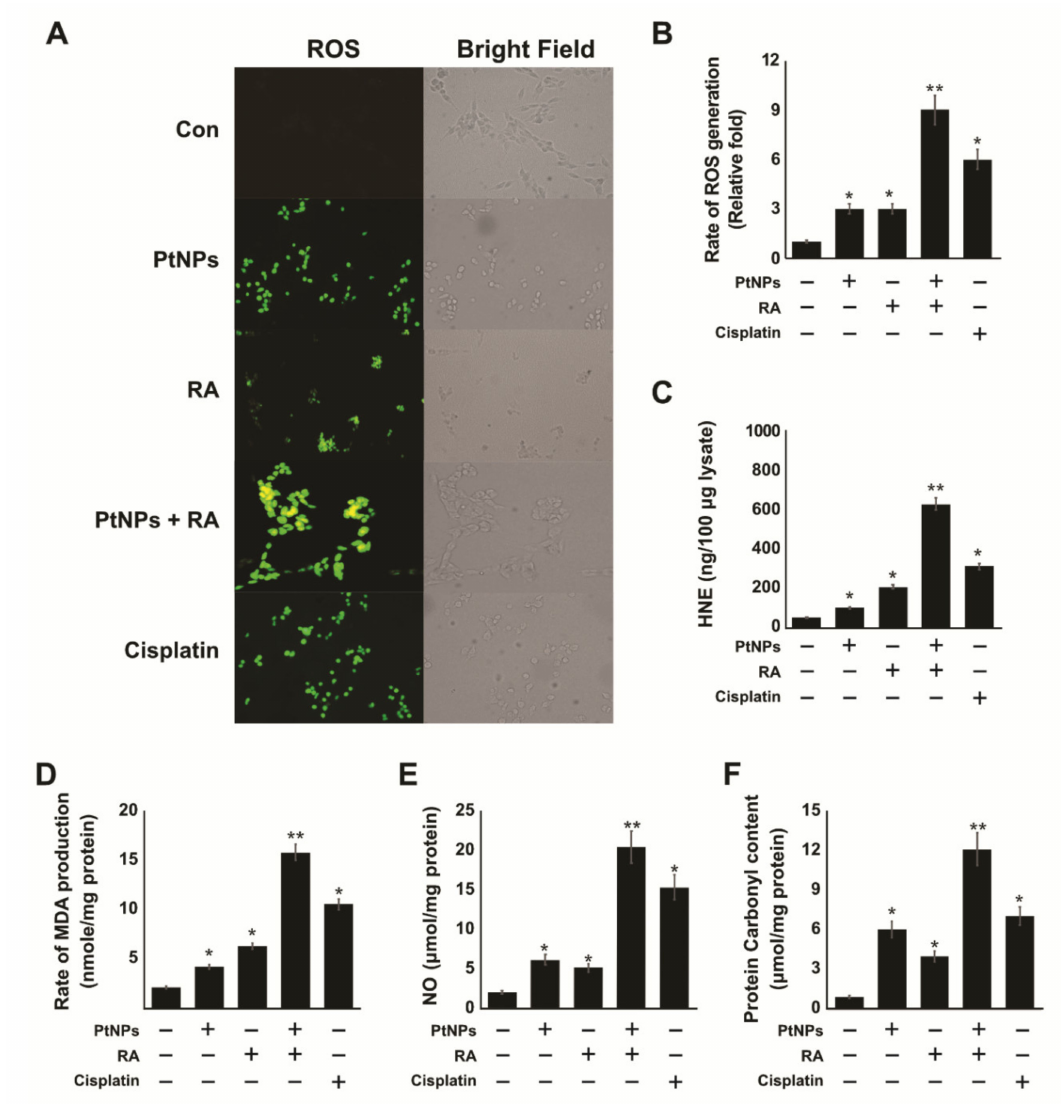
Figure 6. PtNPs and RA increase the generation of ROS, lipid peroxidation, nitric oxide (NO) level, and protein carbonylation. SH-SY5Y cells were incubated with PtNPs (25 µ g / mL), RA (12.5 µ M), combination of PtNPs (25 µ g / mL) and RA (12.5 µ M), or cisplatin (6.5 µ M) for 24 h. Treated SH-SY5Y cells were subjected to 2 (cid:48) ,7 (cid:48) -dichlorodihydrofluorescein diacetate-fluorescein isothiocyanate (DCFH-DA-FITC) analysis ( A ) (Scale bar-100 µ m). Spectrophotometric analysis of ROS using 2 (cid:48) ,7 (cid:48) -dichlorodihydrofluorescein diacetate (DCFH-DA) ( B ). 4-HNE level was determined using enzyme-linked immunosorbent assay (ELISA) ( C ). MDA concentration was measured using a thiobarbituric acid-reactive substances assay and was expressed as nanomoles per gram of protein ( D ). NO production was quantified spectrophotometrically using the Griess reagent and expressed as µ M per g of protein ( E ). Protein carbonylation content was determined and expressed as µ M per g of protein ( F ). The results are expressed as mean ± standard deviation of three independent